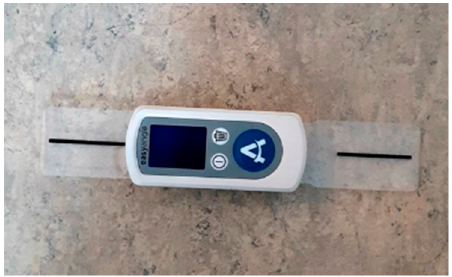
Figure 1. Digital goniometer, EasyAngle. (Photo: Nicole Gandre Lauridsen).